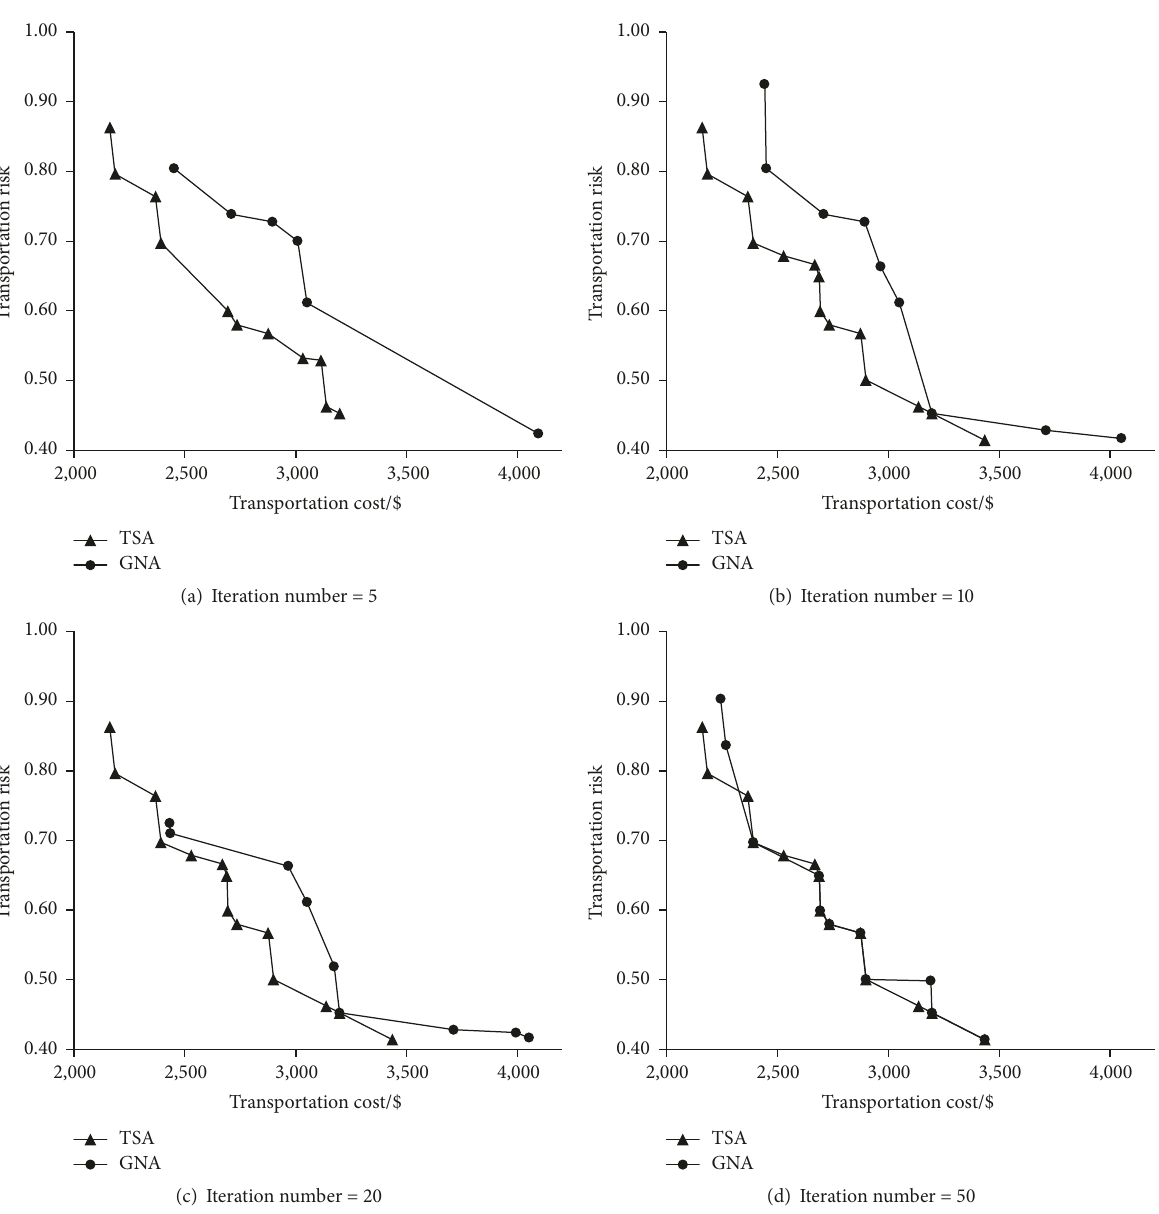
Figure 6: Pareto solutions obtained in path